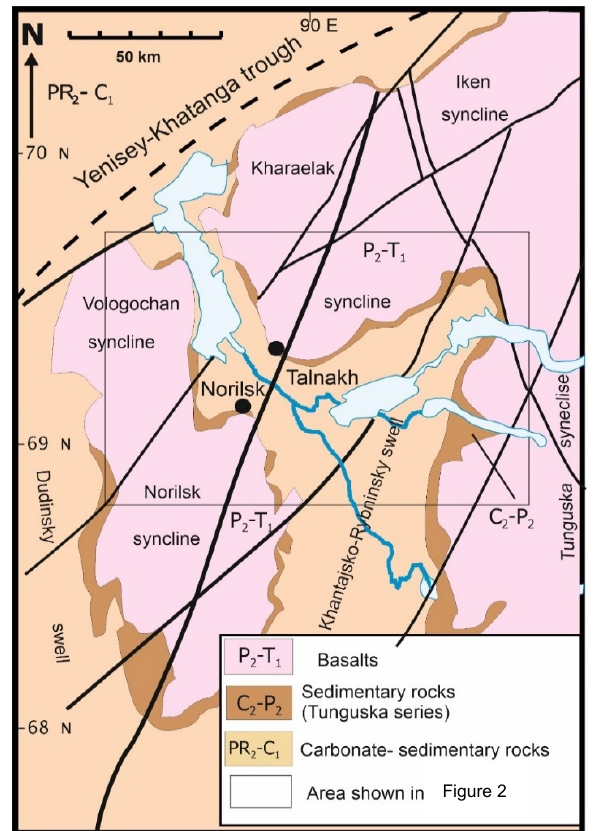
Figure 1. Schematic geological map of the Norilsk area.